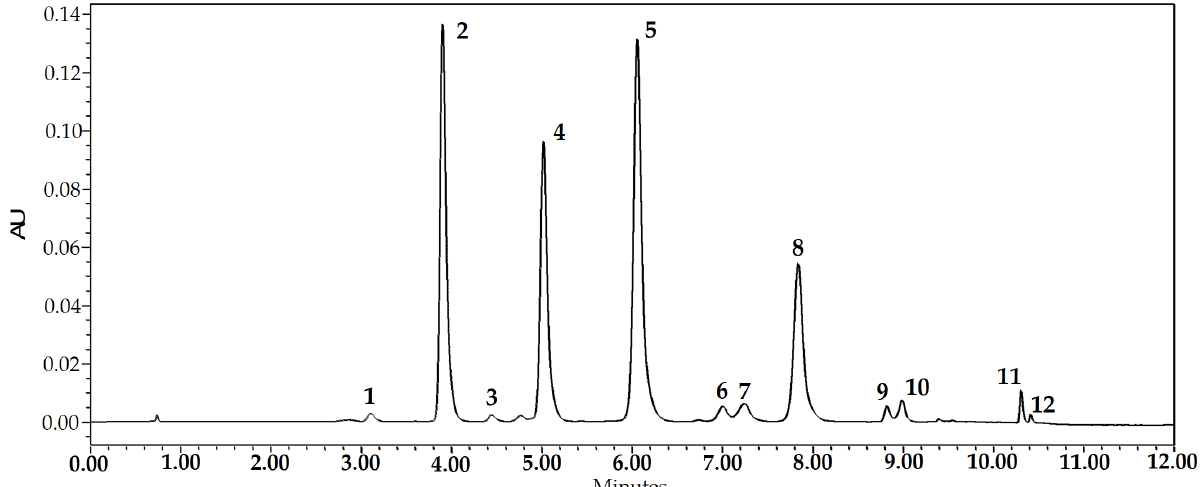
Figure 1. Chromatogram profile of anthocyanins and anthocyanidins in the extract of large cran- berry fruit samples at 520 nm. 1—delphinidin-3-galactoside; 2—cyanidin-3-galactoside; 3—cya- cranberry fruit samples at 520